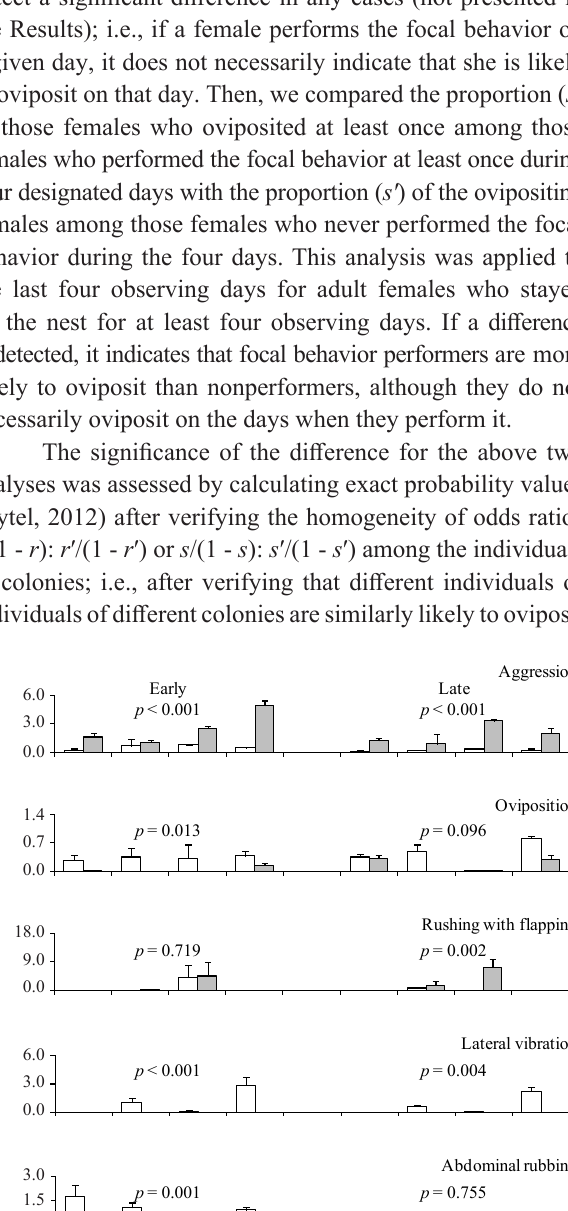
a Left, males; right, females. Colony 5 collapsed just before the reproductives were assumed to emerge. b Numbers in parentheses are the number of eggs for each ovipositing worker. The numbers before and after each en dash indicate the emergence order of the workers and the frequency of oviposition, respectively.